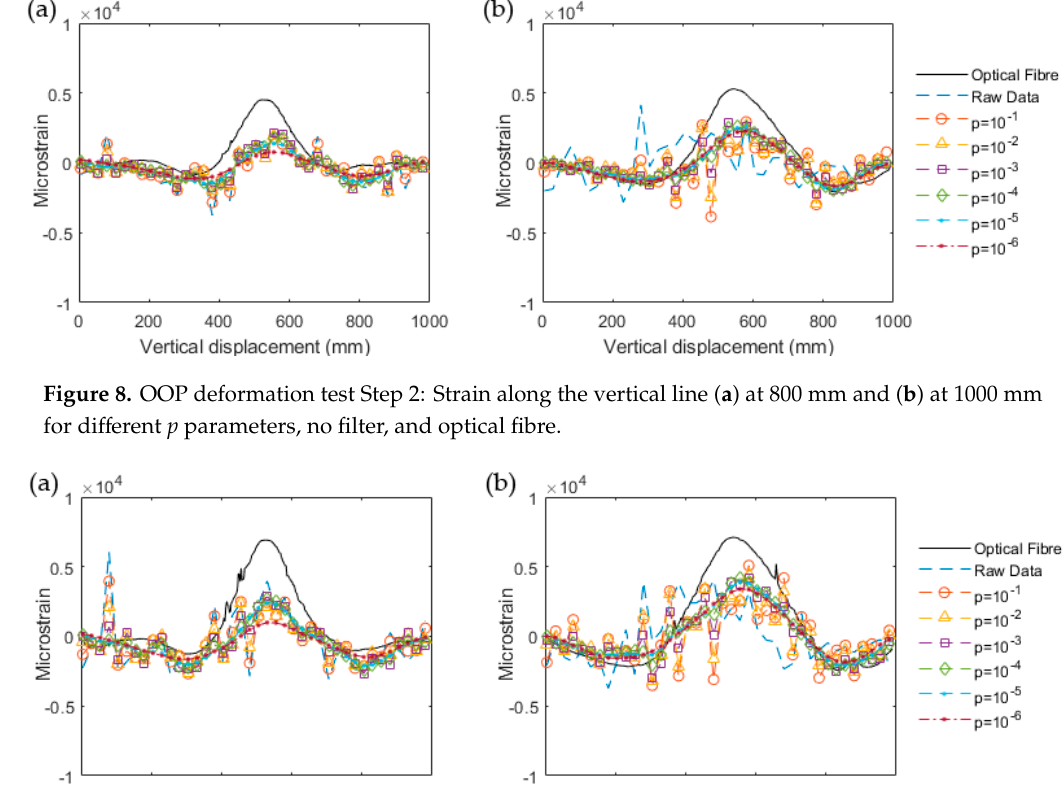
Figure 10. OOP deformation test Step 4: Strain along the vertical line ( a ) at 800 mm and ( b ) at 1000 mm for different (cid:1868) parameters, no filter, and optical fibre.